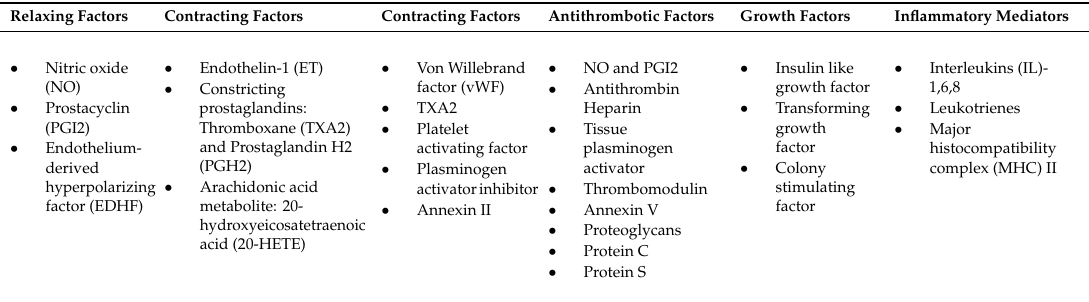
Table 1. Factors produced by the endothelium that contribute to vascular